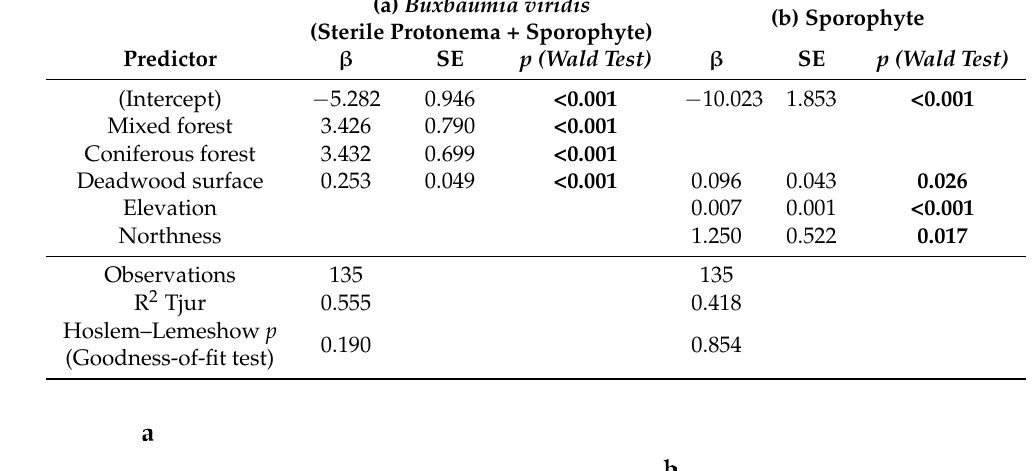
Table 2. Logistic regression results after model simplification using stepwise selection procedure